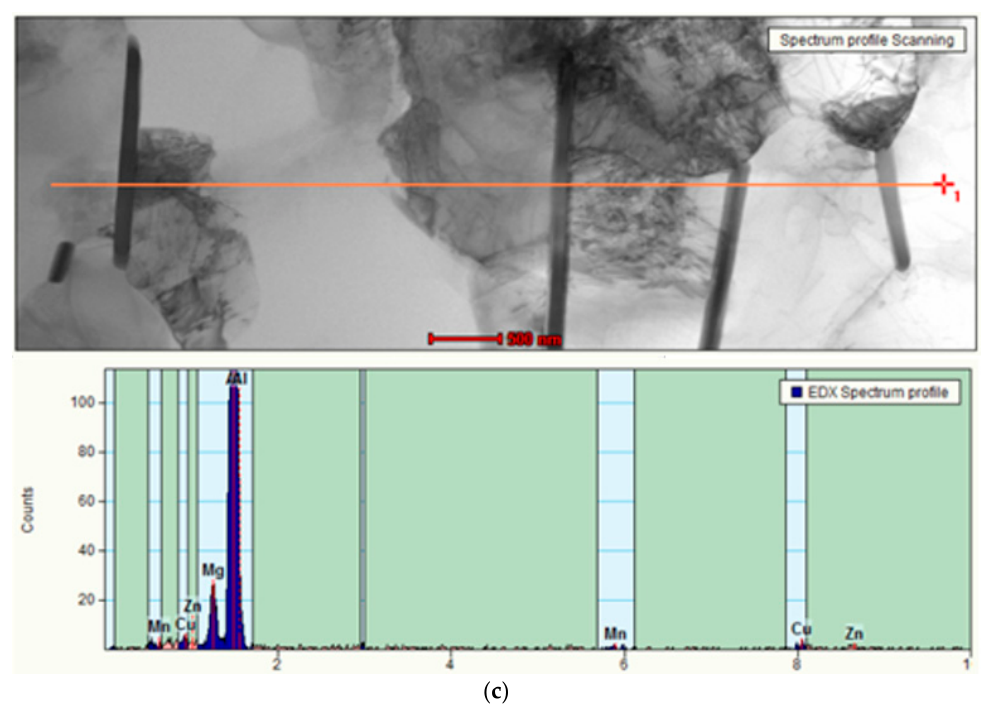
Figure 10. Transmission electronic microscopy of the 5Mg0.5Mn alloy ( a ); EDS results for the 5Mg0.5Mn alloy ( b , c ).